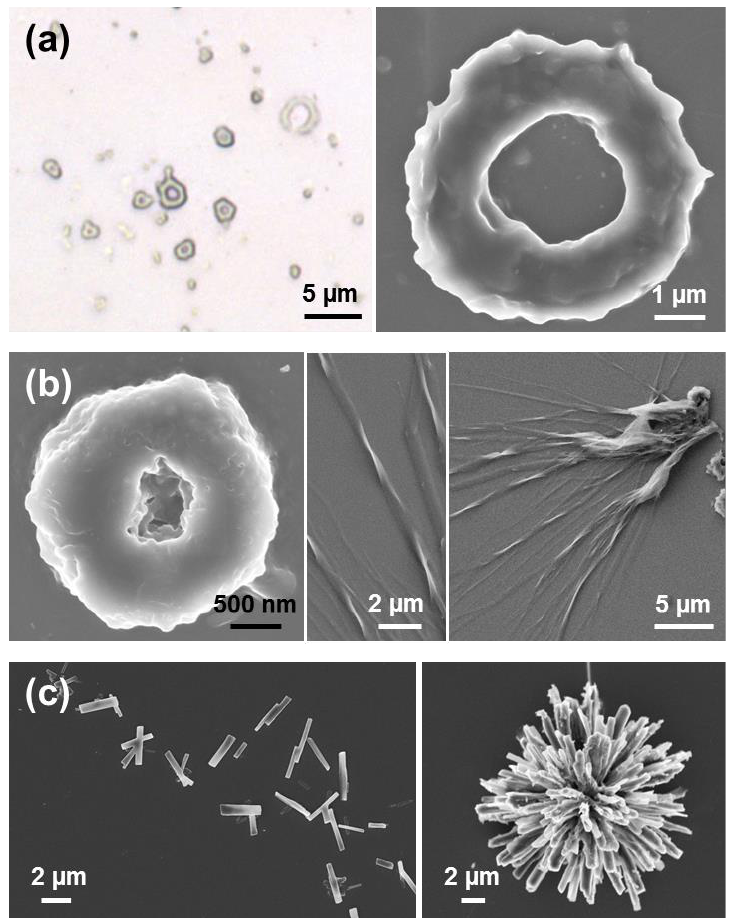
Figure 6. ( a , left) Optical microscopy and ( a – c ) SEM images of the structures obtained from FFF solutions in ( a ) 1:99 HFIP:MeOH (0.05 mg/mL), ( b ) 1:99 HFIP: i PrOH (0.05 mg/mL), and ( c ) 1:49 HFIP: i PrOH (0.1 mg/mL) mixtures.